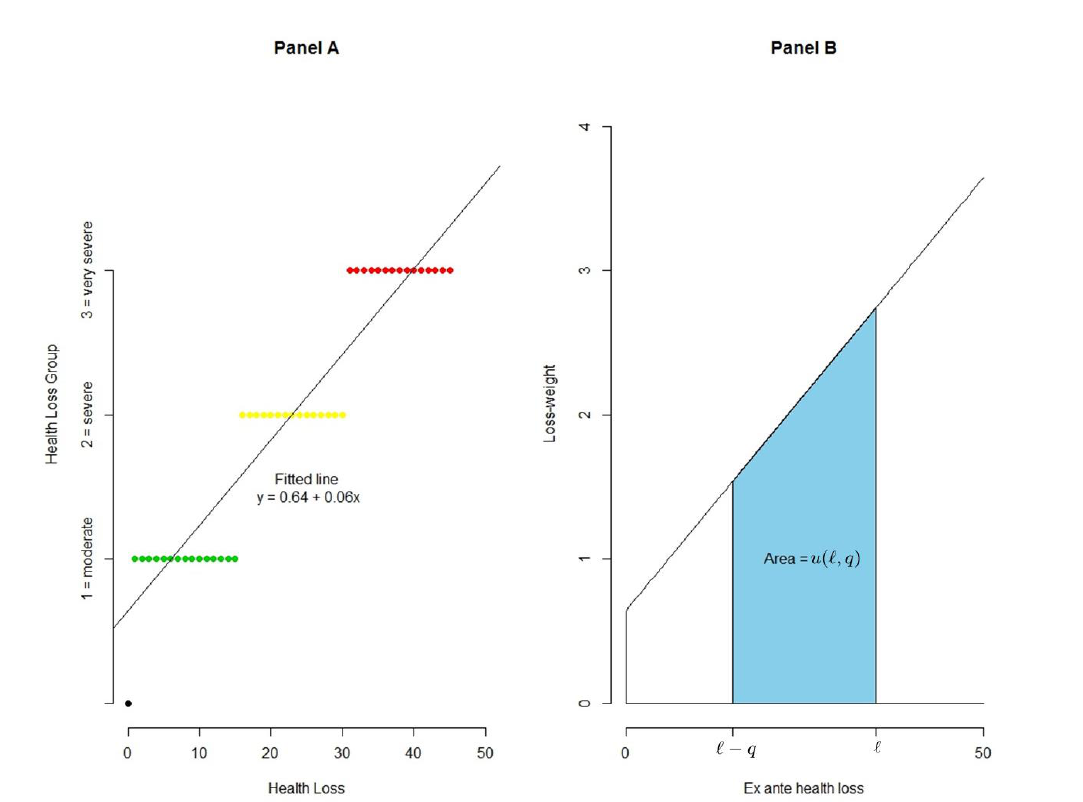
Figure 2: Graphical illustration of step-wise (NOU) vs. balanced